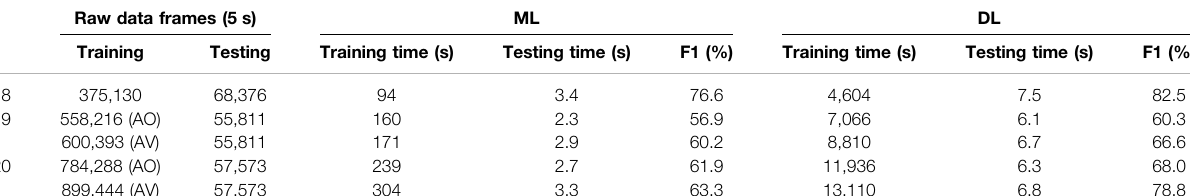
TABLE6| BaselineperformanceforSHL2018 – 2020.AO:theclassi fi eristrainedusingthetrainingdataonly;AV:theclassi fi eristrainedusingboththetrainingandvalidation data.